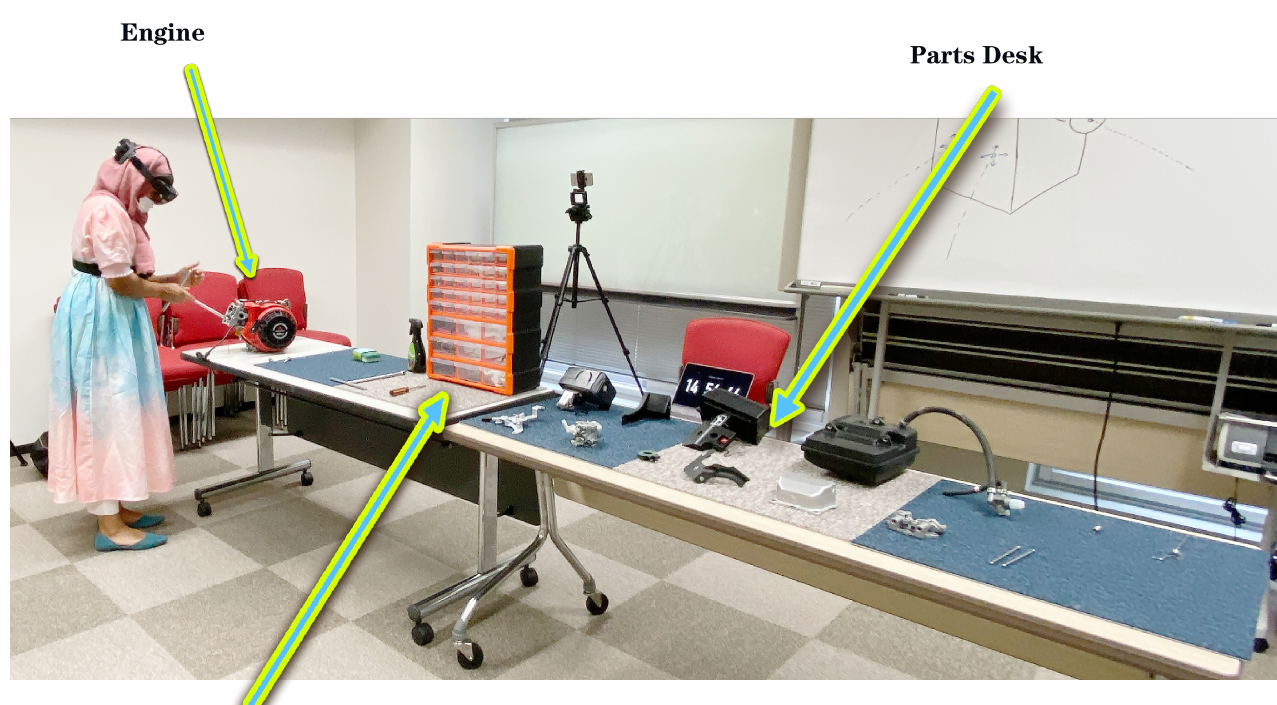
Figure 27. Experimental scene setting of engine maintenance